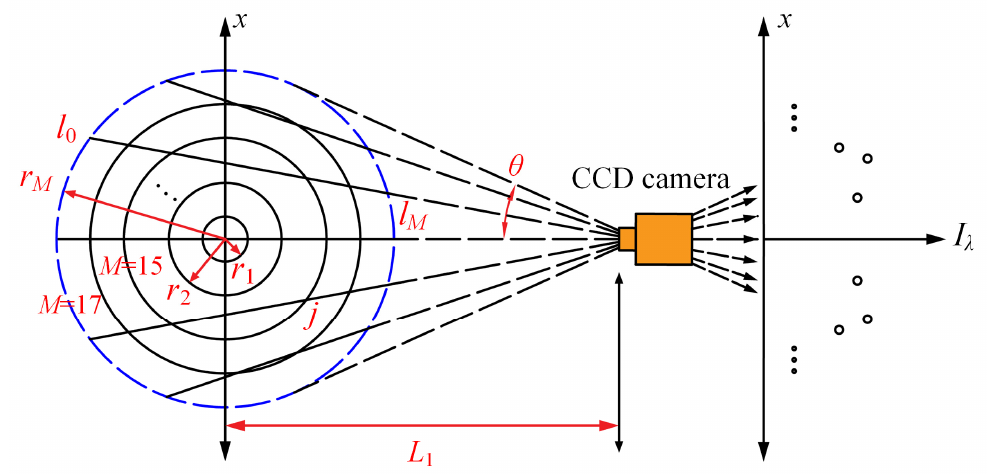
Figure 1. The reconstruction model considering the edge effect.